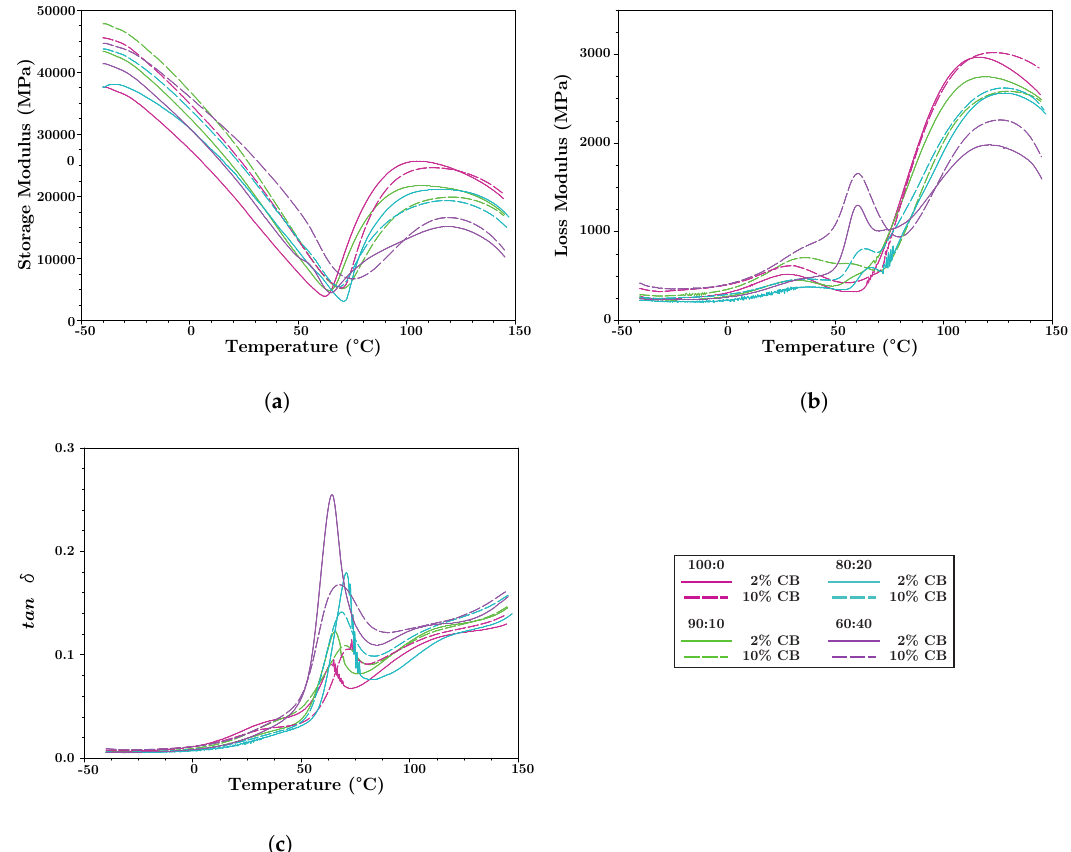
Figure 4. A subset of the DMA data (for 2% and 10% CB) showing: ( a ) Storage modulus, ( b ) loss modulus, and ( c ) loss tangent (tan δ ) for PHBV:PLA = 100:0, 90:10, 80:20, and